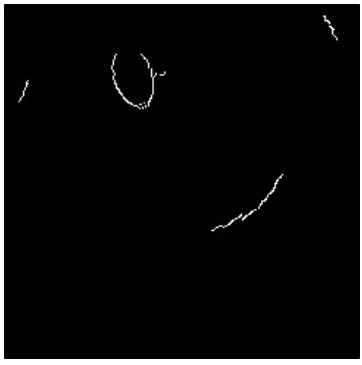
Figure 37. Reflective highlight contour.